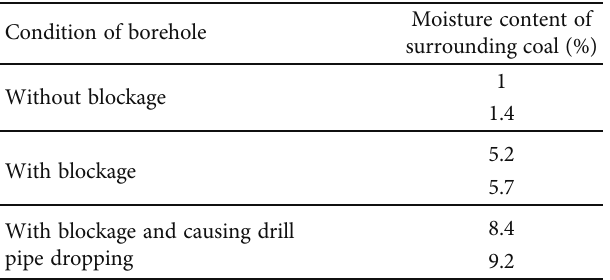
Table 4: Moisture contents of coal as a function of the condition of